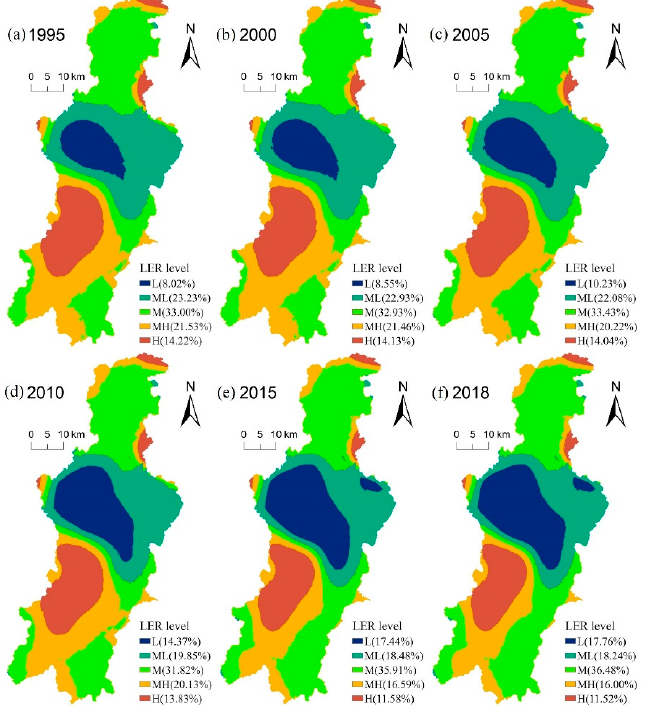
Figure 4. Spatial pattern and proportion changes of the LER in the Dianchi Lake basin of China in ( a ) 1995, ( b ) 2000, ( c ) 2005, ( d ) 2010, ( e ) 2015, ( f ) 2018. Note: L (low), ML (medium-low), M (medium), MH (med-high), H (high).